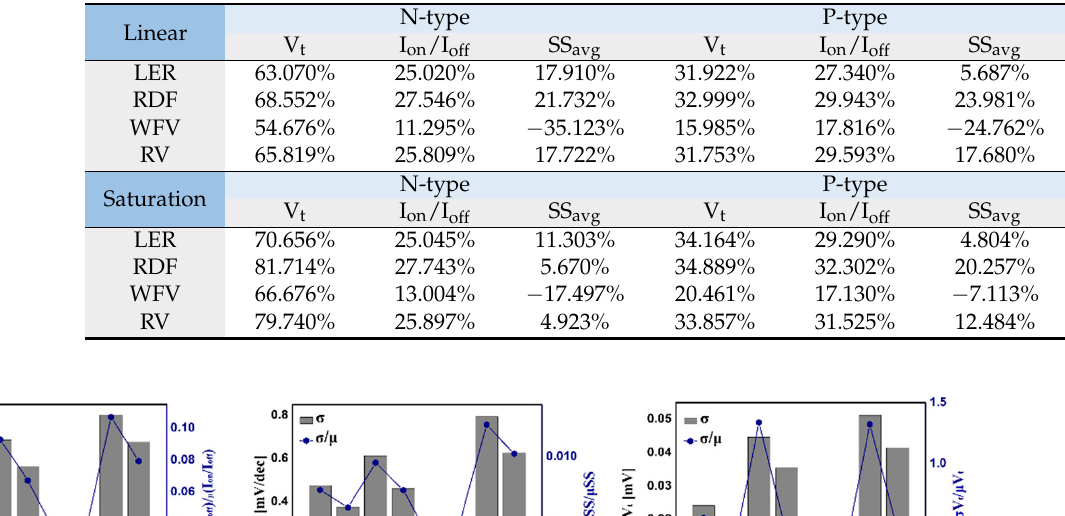
Table 6. Percentage of difference in value of σ / µ for NC-JL-NWFET compared to the JL-NWFET in linear and saturation modes.